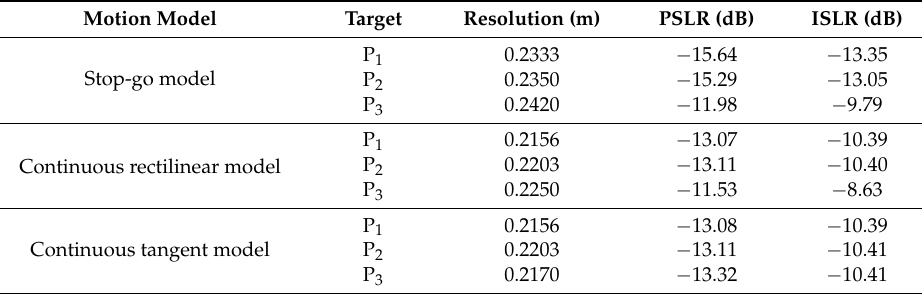
Table 4. Evaluation of imaging quality along